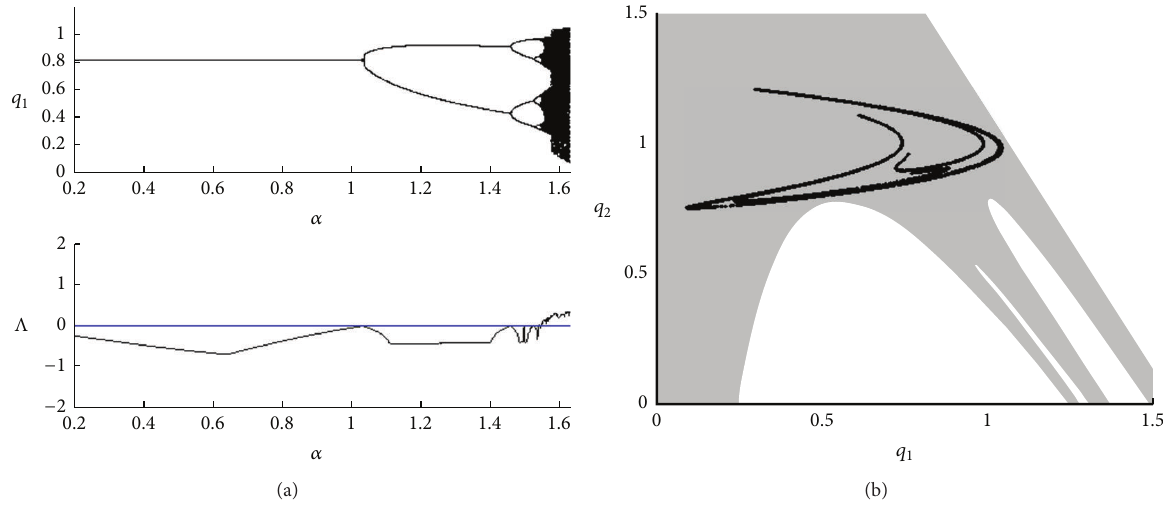
Figure 6: Parameter set: 𝑎 = 3 , 𝑏 = 1 , 𝑐 = 0.5 , and 𝛾 = 0.963 . (a) Bifurcation diagram of map 𝑀 2 and the corresponding Lyapunov exponent ( Λ ) for 𝛼 ∈ [0.2, 1.63] . (b) Chaotic attractor for 𝛼 = 1.61 .